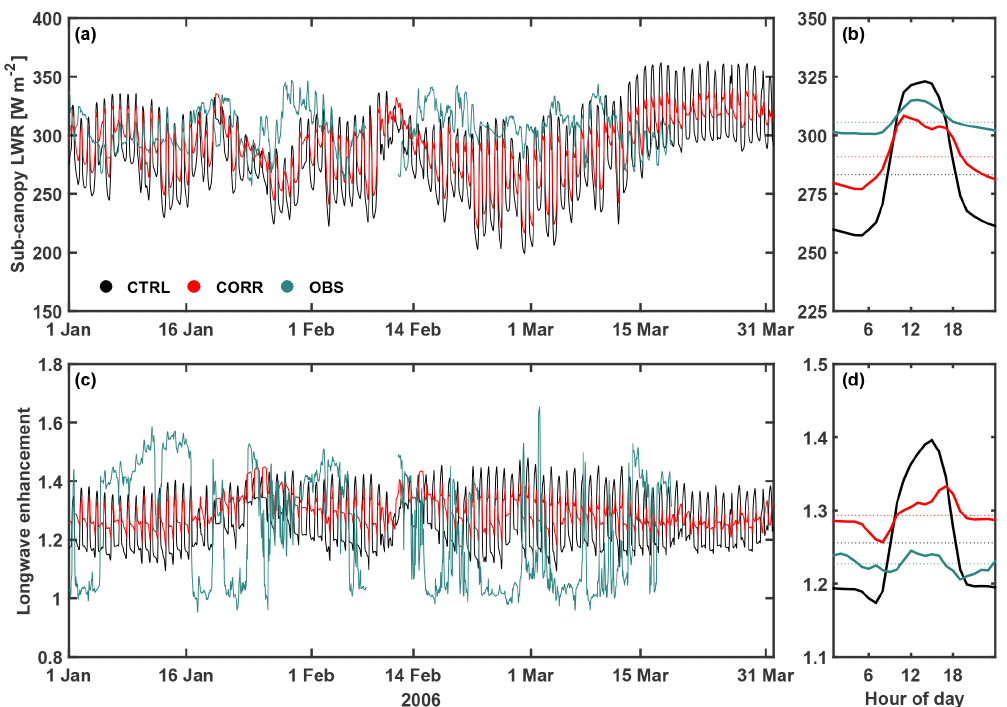
Figure 4. Hourly time series (a, c) , diurnal cycles (solid in b and d ), and JFM averages (dotted in b and d ) of sub-canopy longwave radiation (a, b) and longwave enhancement (c, d) for the snowmelt season in 2006 at Alptal, Switzerland. Measurements at the forest stand (OBS; green) are shown for comparison with offline simulations CTRL (black) and CORR (red) for boreal evergreen needleleaf trees in the corresponding grid cell of Alptal, Switzerland. Gaps in measurements are due to quality checks and excluded from calculation of diurnal cycle and JFM average.